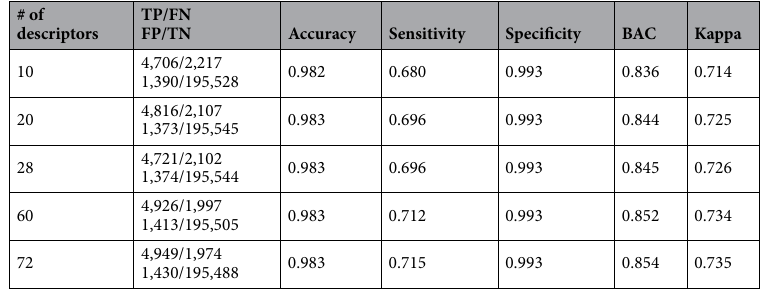
Table 3. Statistical results of 5-fold cross validation for promising Pareto